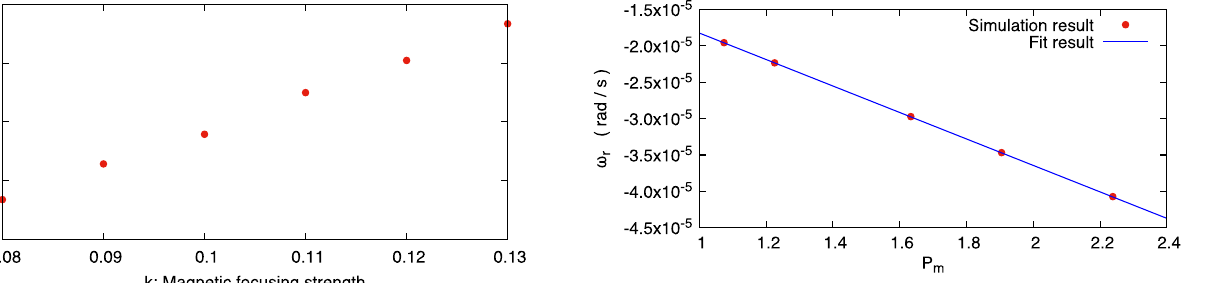
s.FIG. 7. The vertical tune vs the magnetic quadrupole strength in units of T/m with alternating sign quadrupoles. In addition to the magnetic tune, there is also electric focusing due to the special shaping of the electric field plates with a field focusing index of m ¼ 0 . 1